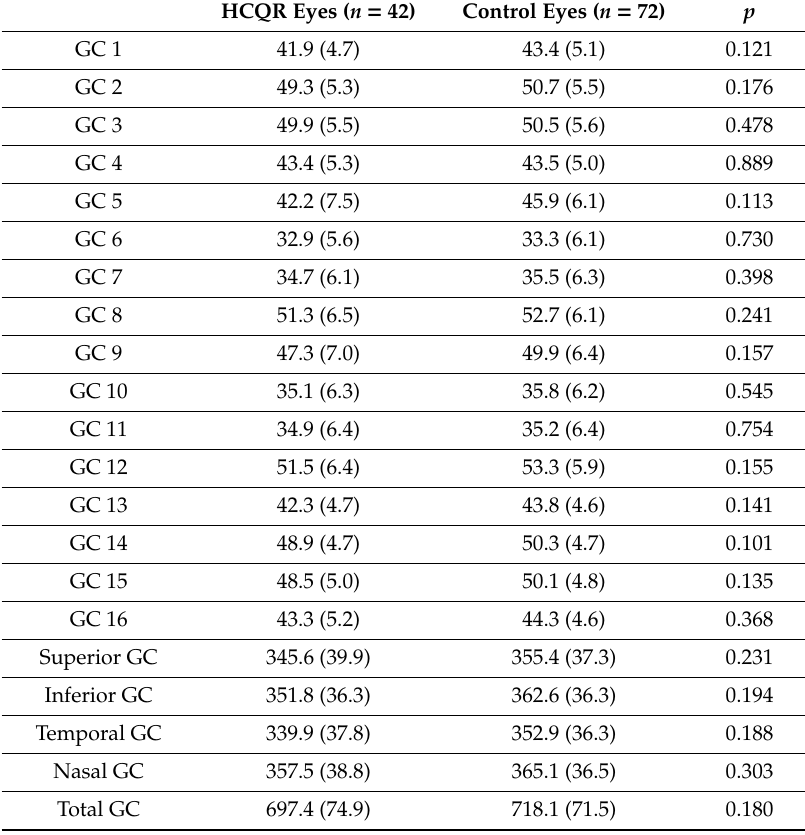
Table 3. Comparison of ganglion cell (GC) layer between hydroxychloroquine retinopathy (HCQR) eyes and control eyes. Data for quantitative variables are shown as mean (standard deviation). Analysis was performed using the Mann–Whitney